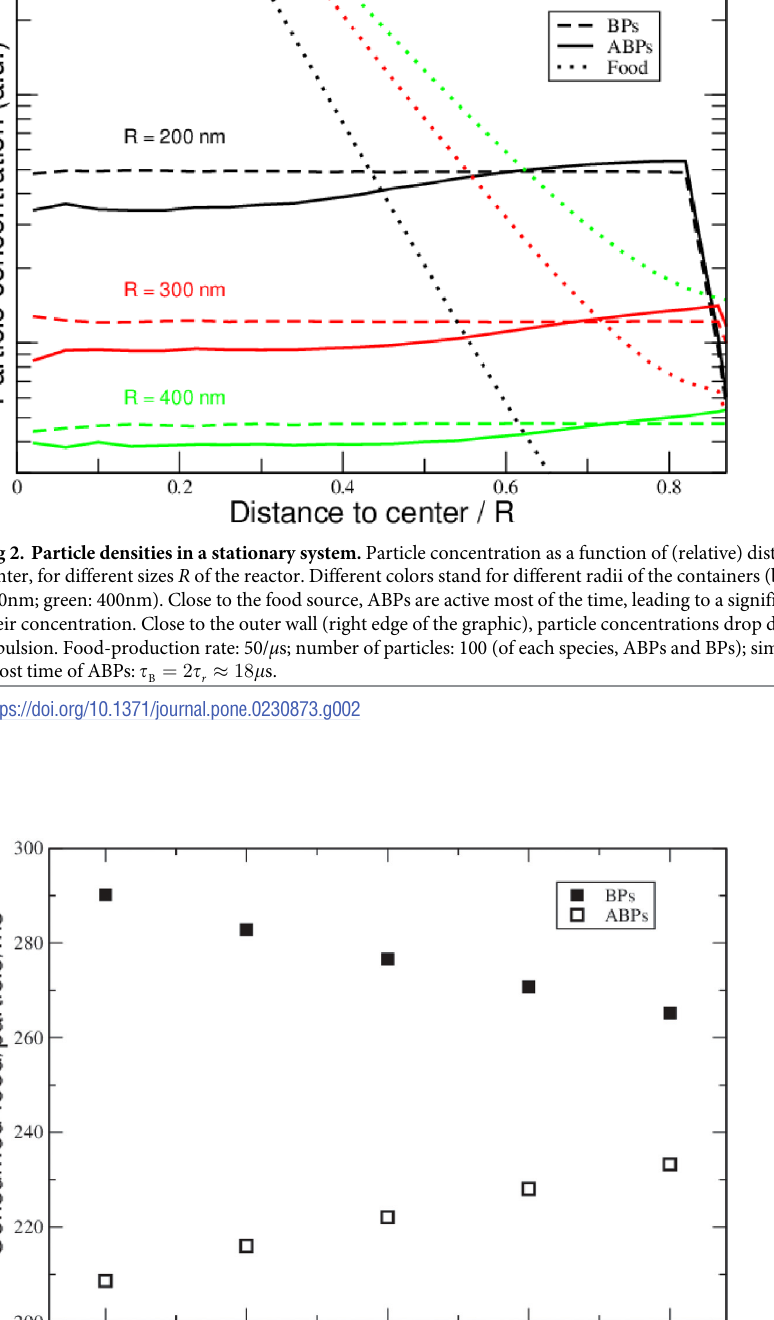
PLOS ONE | https://doi.org/10.1371/journal.pone.0230873 April 8,